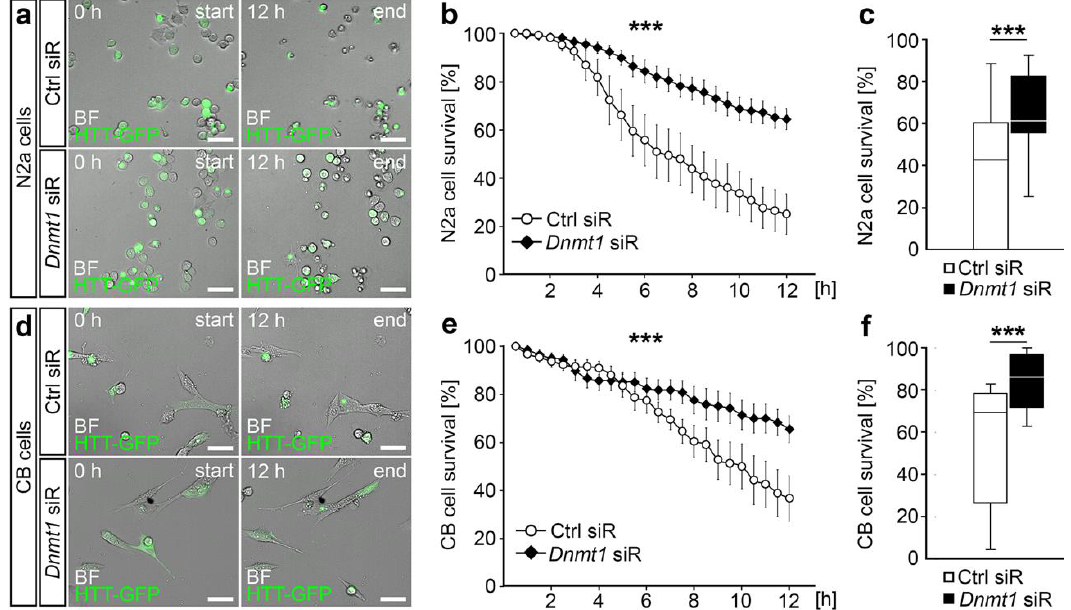
Figure 3. Dnmt1 knockdown ameliorated the cell survival upon mutant HTT-induced cytotoxicity. ( a ) Representative microphotographs of start and end points of the 12 h time interval used to perform the HTT cytotoxicity assay in N2a cells expressing GFP-labeled mutant HTT (green). Cells were transfected with either Ctrl or Dnmt1 siRNA. ( b ) Cell survival rate quantification of N2a cells expressing GFP-labeled mutant HTT and transfected with Ctrl siRNA ( n = 4 experiments, n = 274 cells) or Dnmt1 siRNA ( n = 4 experiments, n = 378 cells) over the time course of 12 h in the HTT cytotoxicity assay (two-way ANOVA, *** p < 0.001). ( c ) Comparison of the survival rates of cells analyzed in ( b ) at the final 12 h timepoint (two-tailed Student’s t -test, *** p < 0.001). ( d ) Representative microphotographs of start and end points of 12 h interval used to perform the HTT cytotoxicity assay in CB cells expressing GFP-labeled mutant HTT (green). Cells were transfected with either Ctrl or Dnmt1 siRNA. ( e ) Cell survival rates of CB cells expressing GFP-labeled mutant HTT and transfected with Ctrl siRNA ( n = 100 cells) or Dnmt1 siRNA ( n = 132 cells) over the time course of 12 h in the HTT cytotoxicity assay (two-way ANOVA, *** p < 0.001). ( f ) Comparison of the survival rates of cells analyzed in ( e ) at the 12 h timepoint (two-tailed Student’s t -test, *** p < 0.001). N2a = neuroblastoma cells, CB = cerebellar granule cells, Ctrl = control, HTT = Huntingtin, siR = siRNA, BF = brightfield. Scale bars: 50 µm in ( a , d ).